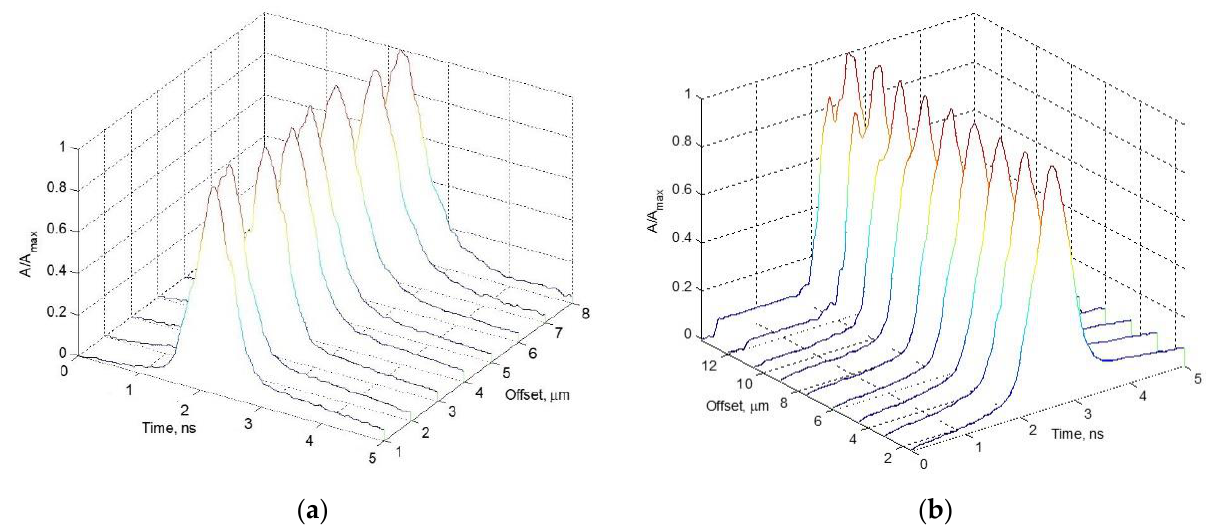
Figure 16. DMD map of 20 m length chiral ESSR-MOF sample: ( a ) 10 revolutions per meter; ( b ) 66 revolutions per meter.